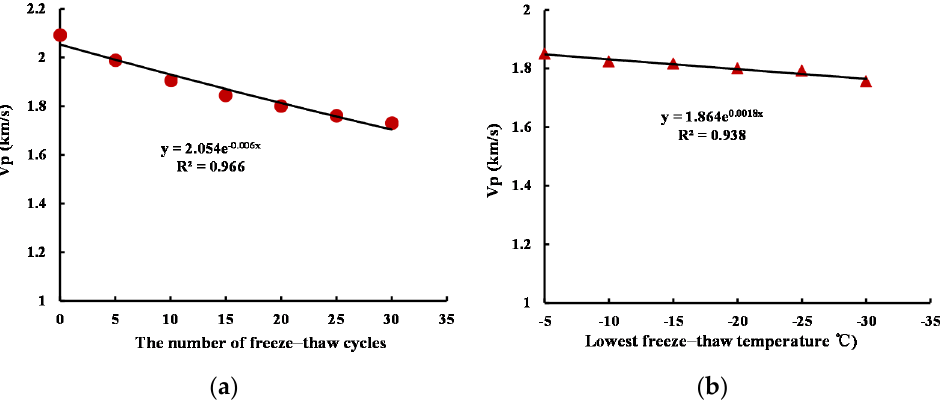
Figure 5. Freeze–thaw cycles and lowest freeze–thaw temperature versus P -wave velocity: ( a ) with different freeze–thaw cycles ( T = − 20 °C); ( b ) with different lowest freeze–thaw temperatures ( N = 20).